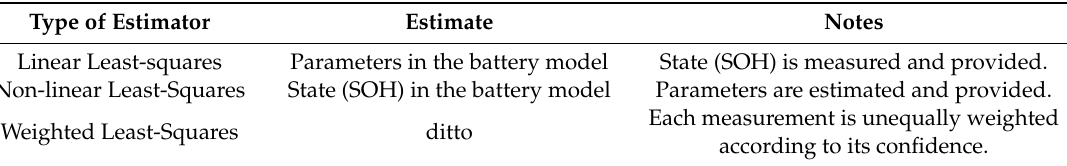
Table 1. Comparison of batch estimators used in the original scheme. Type of Estimator Estimate Notes Linear Least-squares Parameters in the battery model State (SOH) is measured and provided. Non-linear Least-Squares State (SOH) in the battery model Parameters are estimated and provided. Each measurement is unequally weighted Weighted Least-Squares ditto according to its